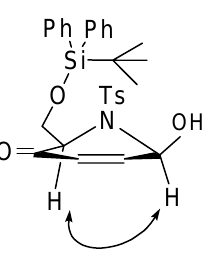
Figure 2. NOE Correlations in 5